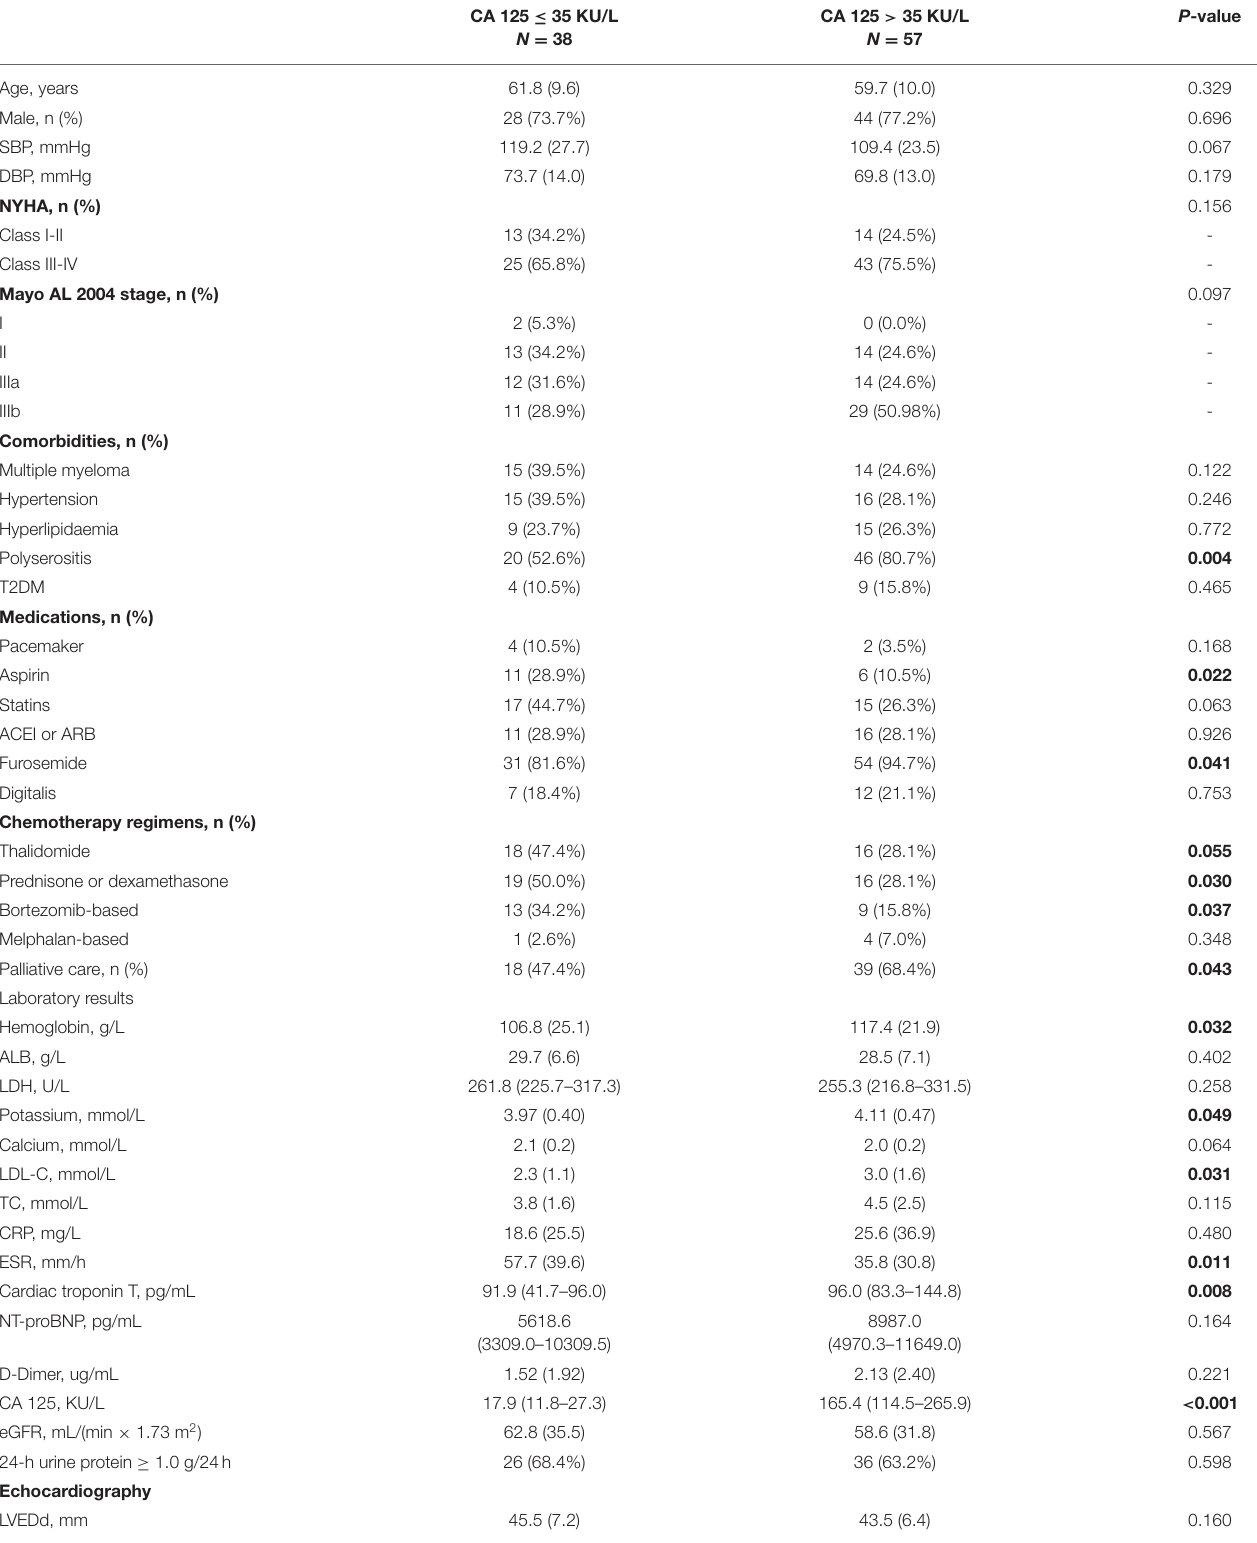
TABLE 1 | Characteristics of 95 patients with AL-cardiac